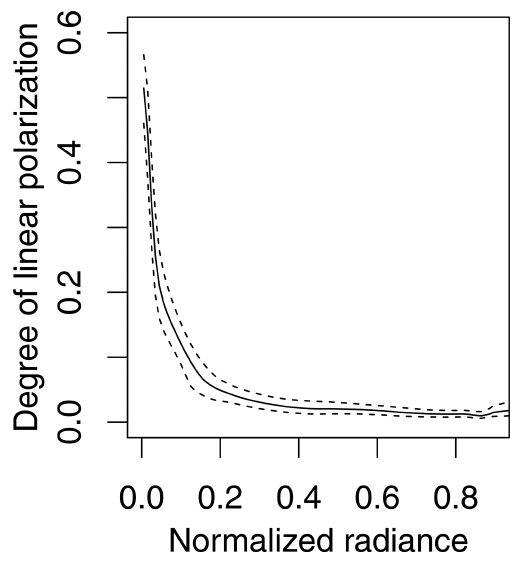
Figure A1. Decreasing trend of the degree of linear polarization for pixels over water with increasing intensity. The solid line is median, and dashed lines are 25th and 75th percentiles (interquartile